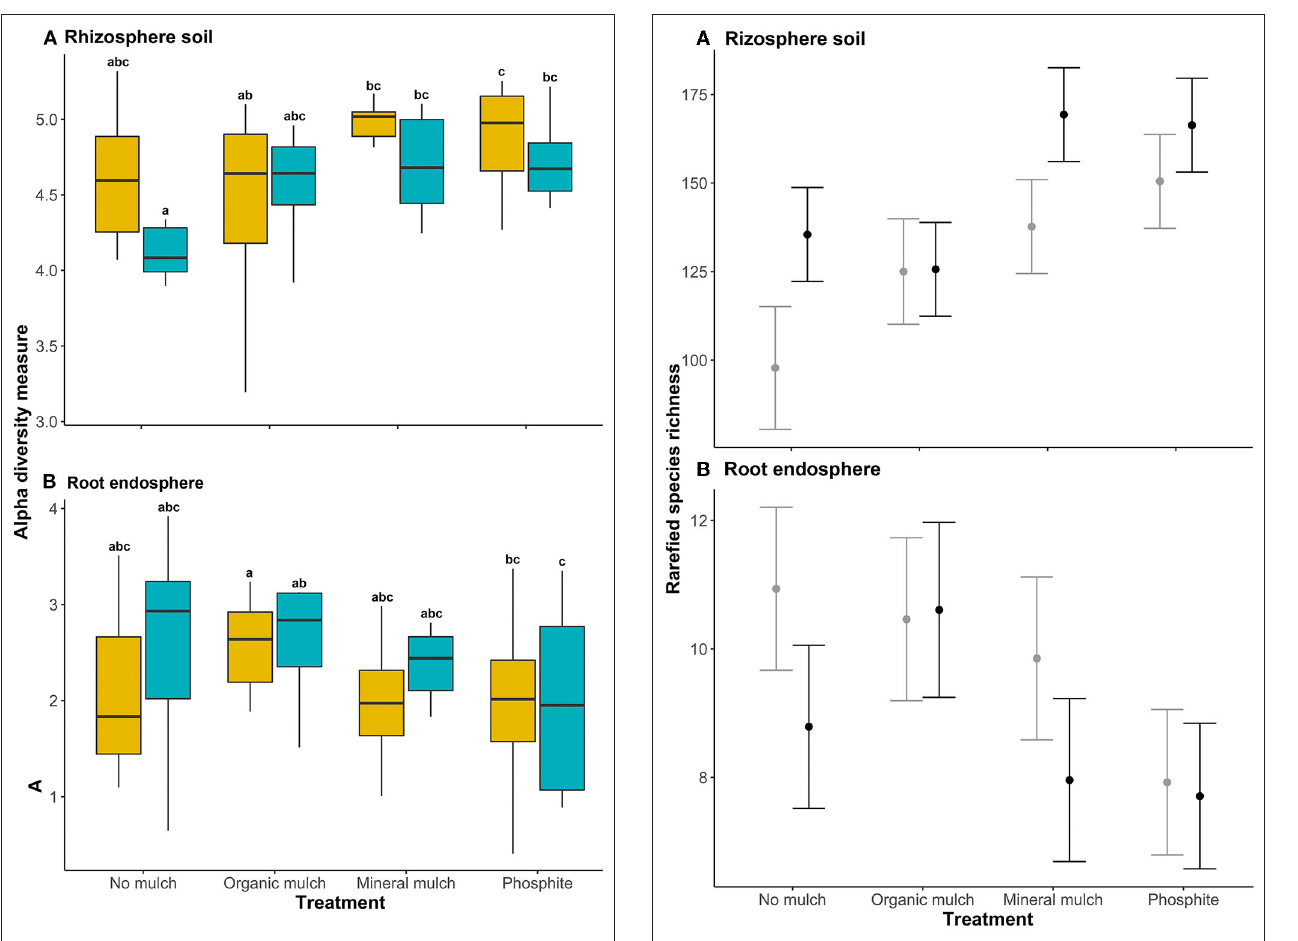
FIGURE 2 | Mean rarefied species richness of the microbial biome of (A) rhizosphere soil, and (B) root endosphere of avocado plants given four soil treatments. Values are estimated marginal means ± standard error. Gray lines indicate values for non-infested plants, black lines plants infested with P. cinnamomi